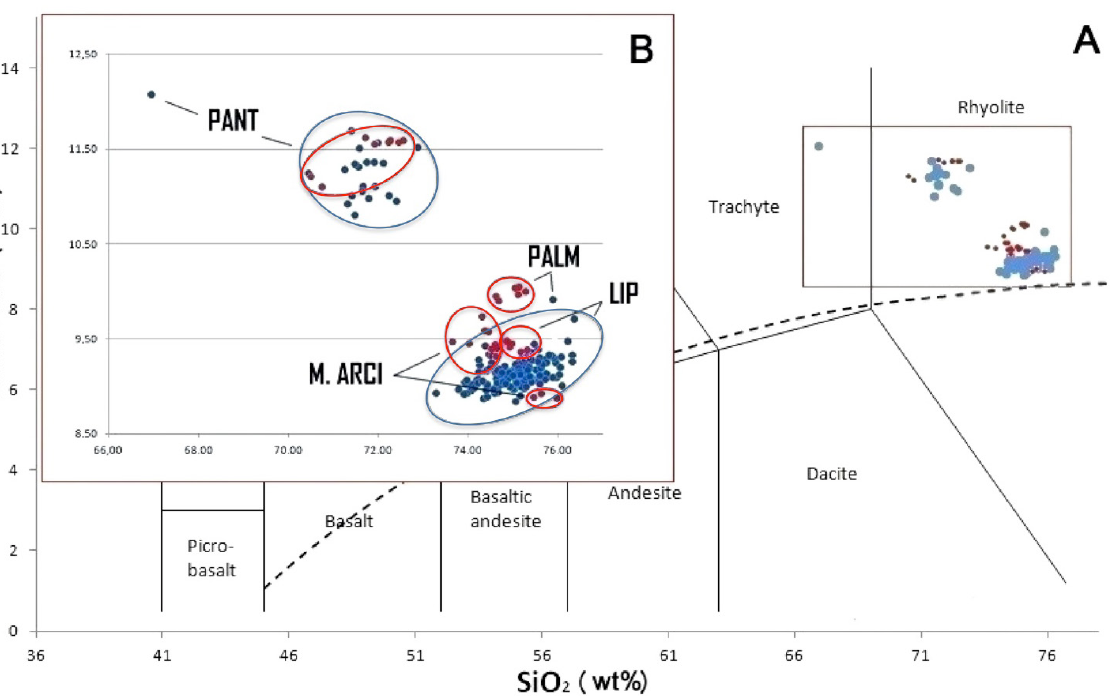
Figure 3: A) Total alkali vs silica diagram of geological (red dots) and archaeological (blue dots) obsidian samples. Classification fields after Le Maitre et al. (2002). In diagram A the dashed line is the boundary between alkaline (up) and subalkaline (down) magmas, after Miyashiro (1978). In the inset B , the red ellipses define the fields of geological samples; the blue ellipses the fields of archeological samples. PANT = Pantelleria, PALM = Palmarola, LIP =